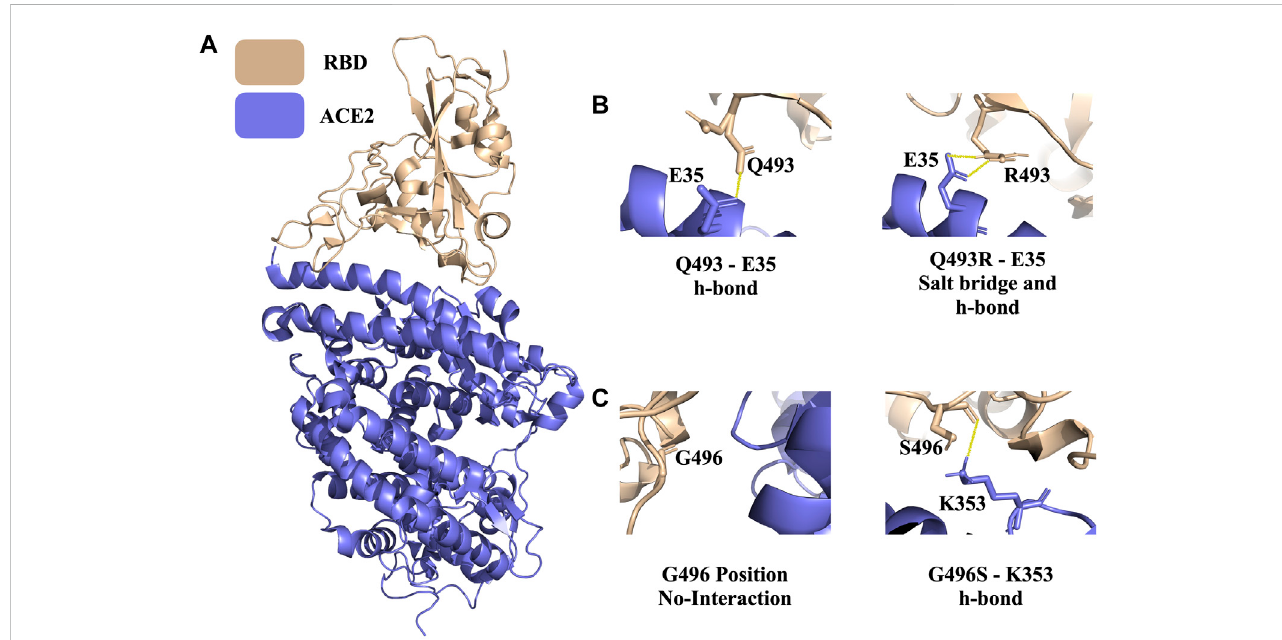
FIGURE 4 PROT-ON results on RBD from the ACE2-RBD complex with 7 Å interfacial cut-off. (A) The structure of the ACE2-RBD complex (PDB ID: 6M0J). Wheat andslatedenoteRBDandACE2,respectively (B) PolarinteractionsofwildtypeQ493andmutantQ493Rareshown(solidyellowline). (C) Thedepictionofthe wild type G496 and mutant G496S. The solid yellow line represents the newly formed